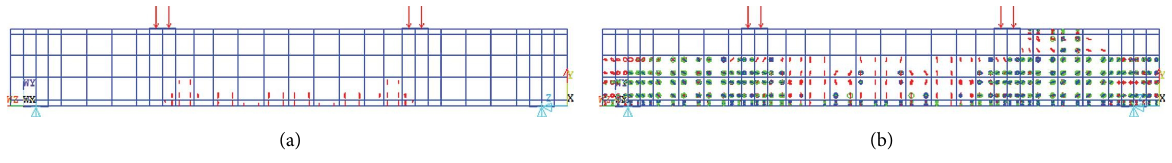
Figure 14: When the stirrup spacings are modifed, cracks begin to appear in the beams, and the beams sufer damage: (a) cracks begin to appear in the beam ( P crack � 8kN), ϕ 6a100; (b) damage to the beam begins to appear ( P max � 125kN), ϕ 6a100.